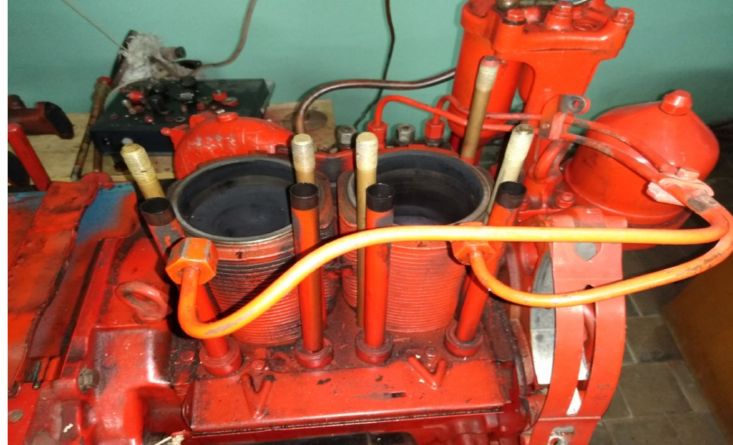
Figure 6. D21A1 diesel engine with dismantled unit heads.